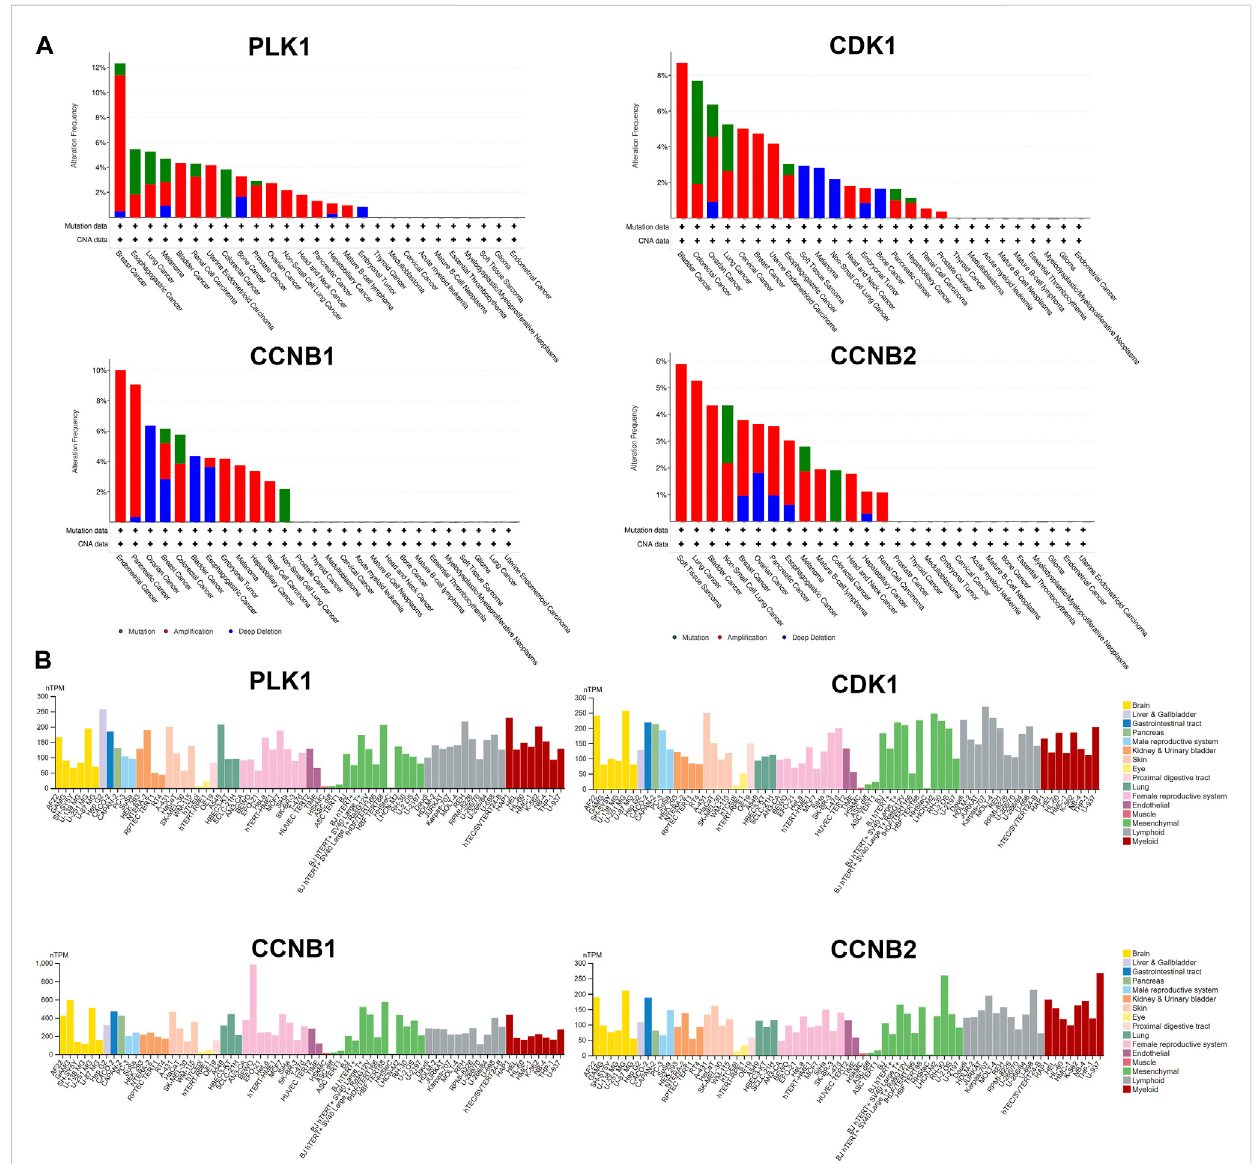
FIGURE 7 Genetic aberration and cell lines speci fi city of hub genes. (A) Genetic alteration analysis of hub genes using cBioPortal. Mutation, ampli fi cation, and deep deletion events were identi fi ed in a pan-cancer analysis of whole genomes (ICGC/TCGA, nature 2020), which includes 2,565 patients/ 2,683 samples. (B) RNA expression data as normalized transcript per million (nTPM) values of tissue culture cell lines from human protein atlas